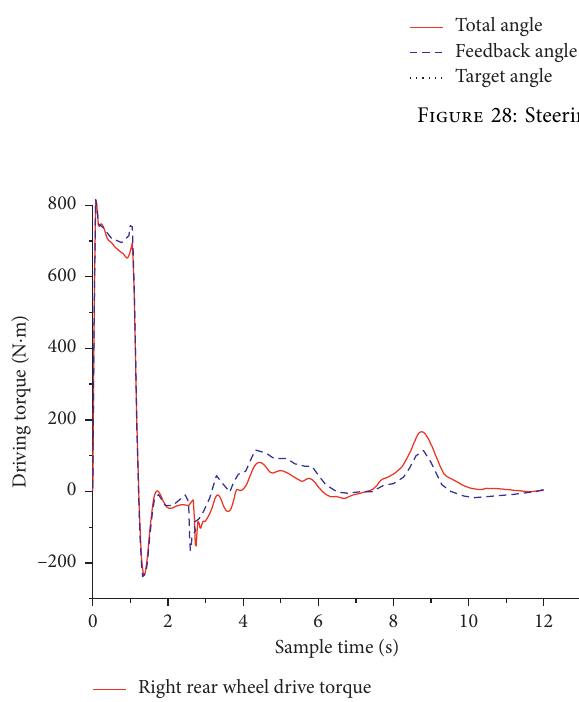
Figure 29: Left and right driving torque simulation